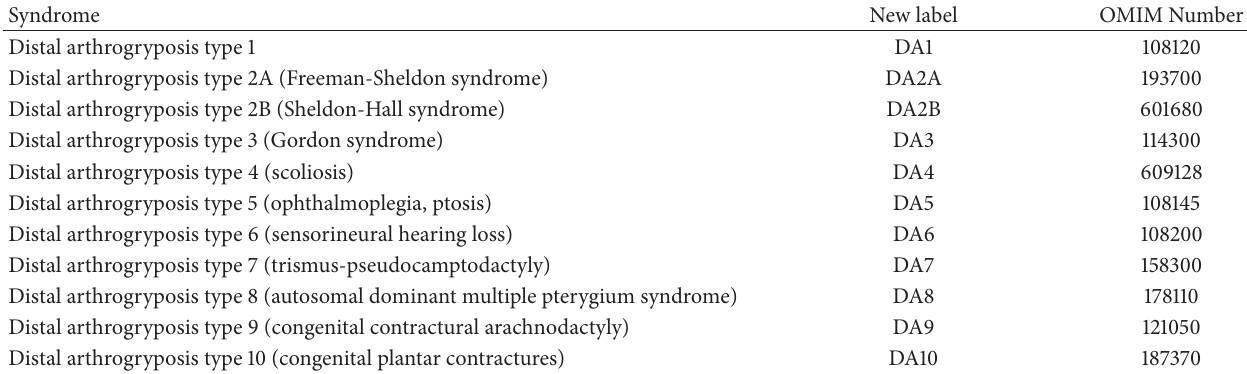
Table 1: Syndrome types, labels, and OMIM Numbers for the distal arthrogryposis ∗